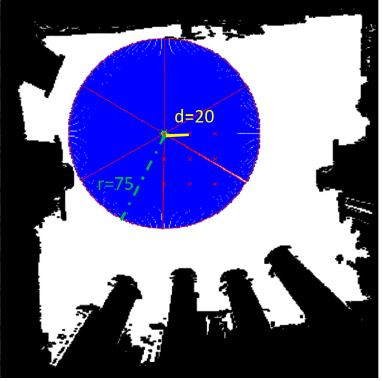
Figure 5. The subgoal configuration in the experiment. The red points represent the subgoal locations. The black and white grids represent the occupied and unoccupied grids, respectively. The blue areas and red lines represent the areas covered and field of view, respectively. The sensor-covered radius is 75 and the distance between subgoals is 20.